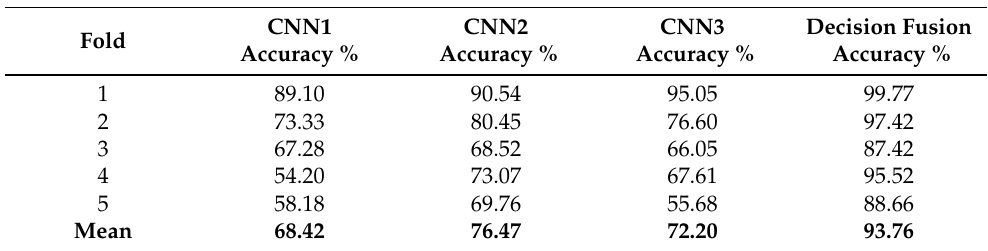
Table 4. Comparison of the classification performance of each single-scale classifier and the proposed multiscale ensemble of classifiers.